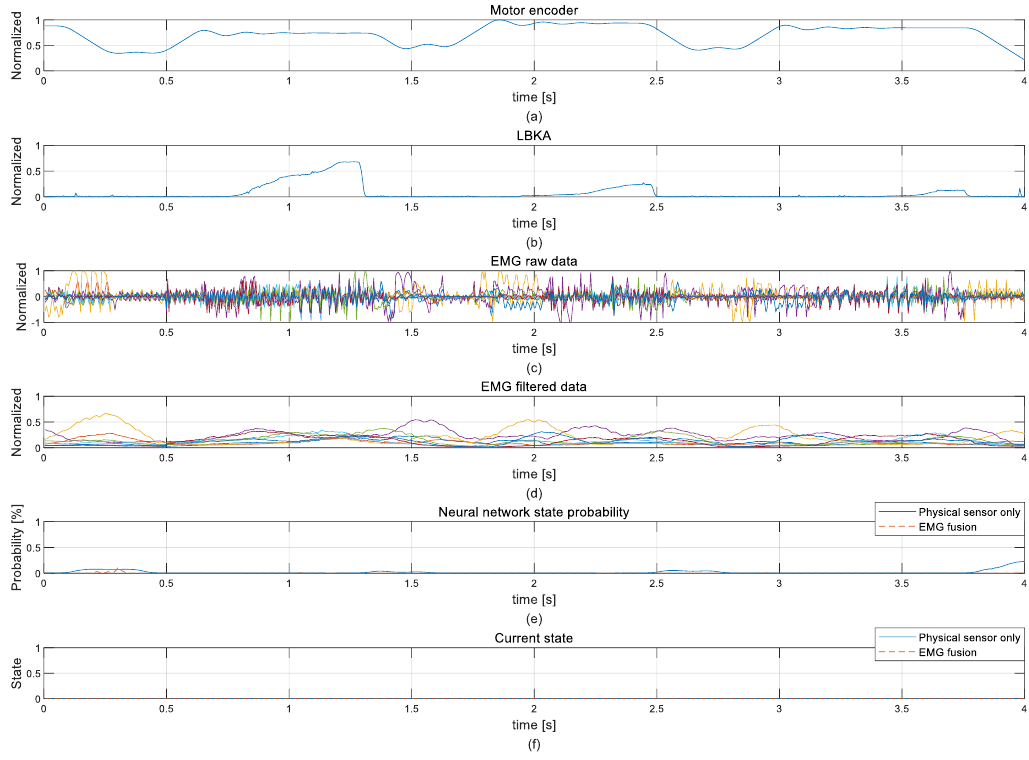
Figure 15. Walking level experimental data for exception state test: ( a ) motor encoder, ( b ) LBKA, ( c ) EMG raw data, ( d ) EMG filtered data, ( e ) NN probability, and ( f ) current state.